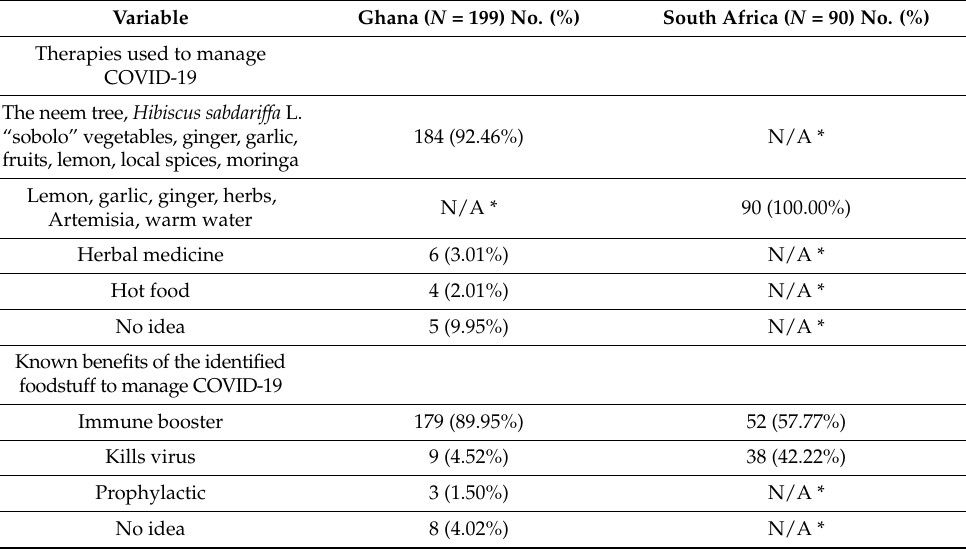
Table 5. Foodstuffs and therapies employed by market women to manage COVID-19.